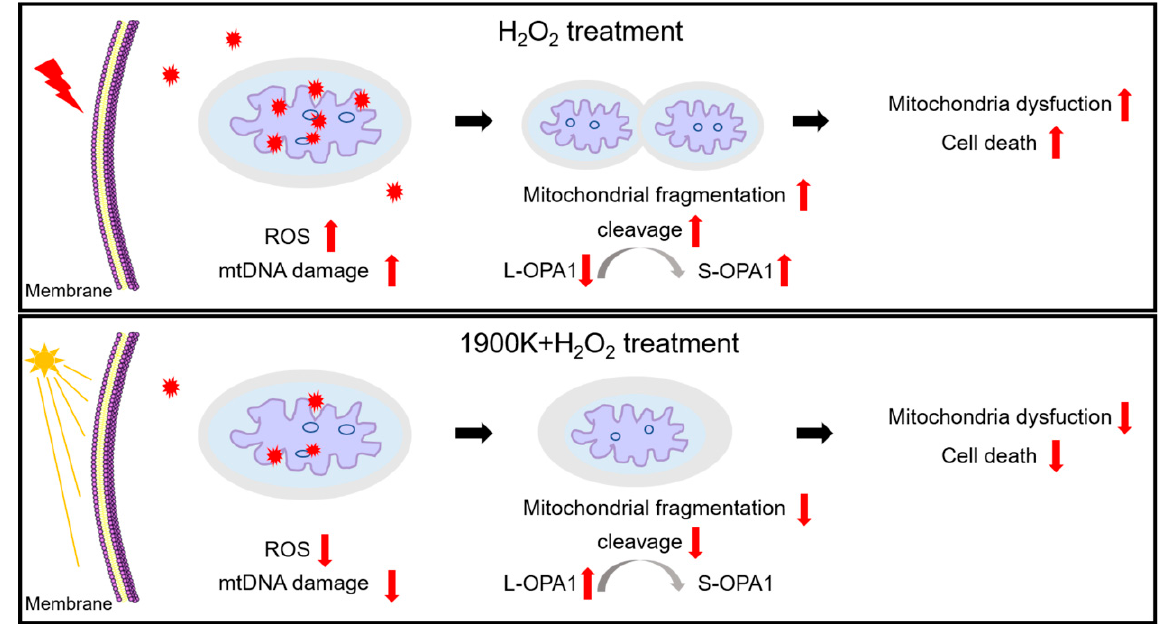
Figure 6. The role of 1900 K LEDs in H 2 O 2 -induced damage in RPE. H 2 O 2 increased intracellular ROS levels, mitochondrial fragmentation, and mitochondrial DNA damage, which led to mitochon- drial dysfunction and, ultimately, cell death. Pretreatment with the 1900 K LEDs could reduce